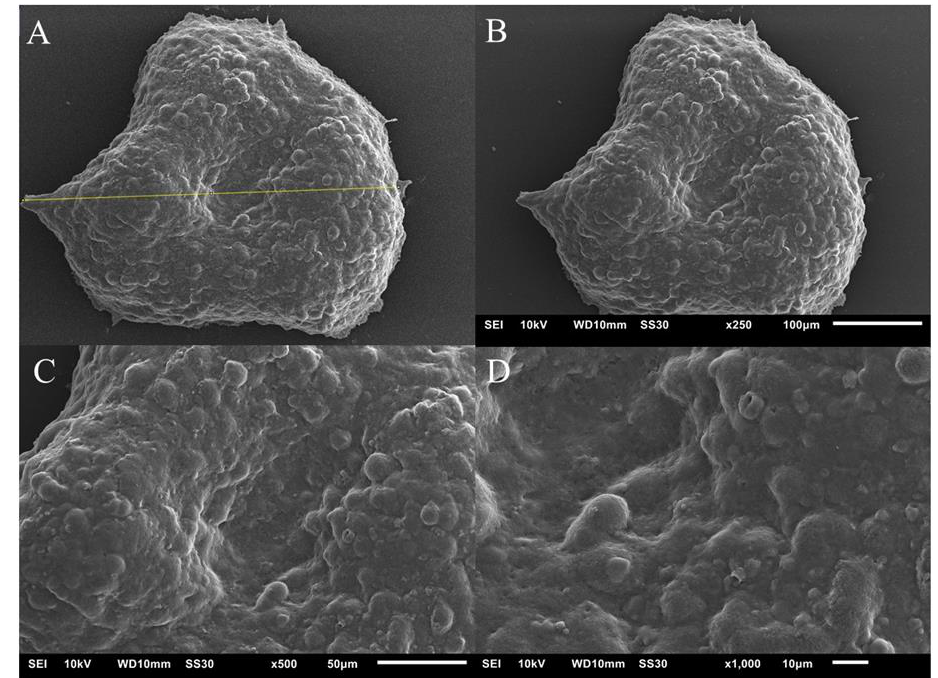
Figure 6. Image of the spheroid of the A549 cell line. ( A ) — the yellow line indicates the diameter of the spheroid, measuring 389.25 µm; ( B ) — spheroid on ×250 objective; ( C ) — image on ×500 objective and ( D ) — ×1000 objective.